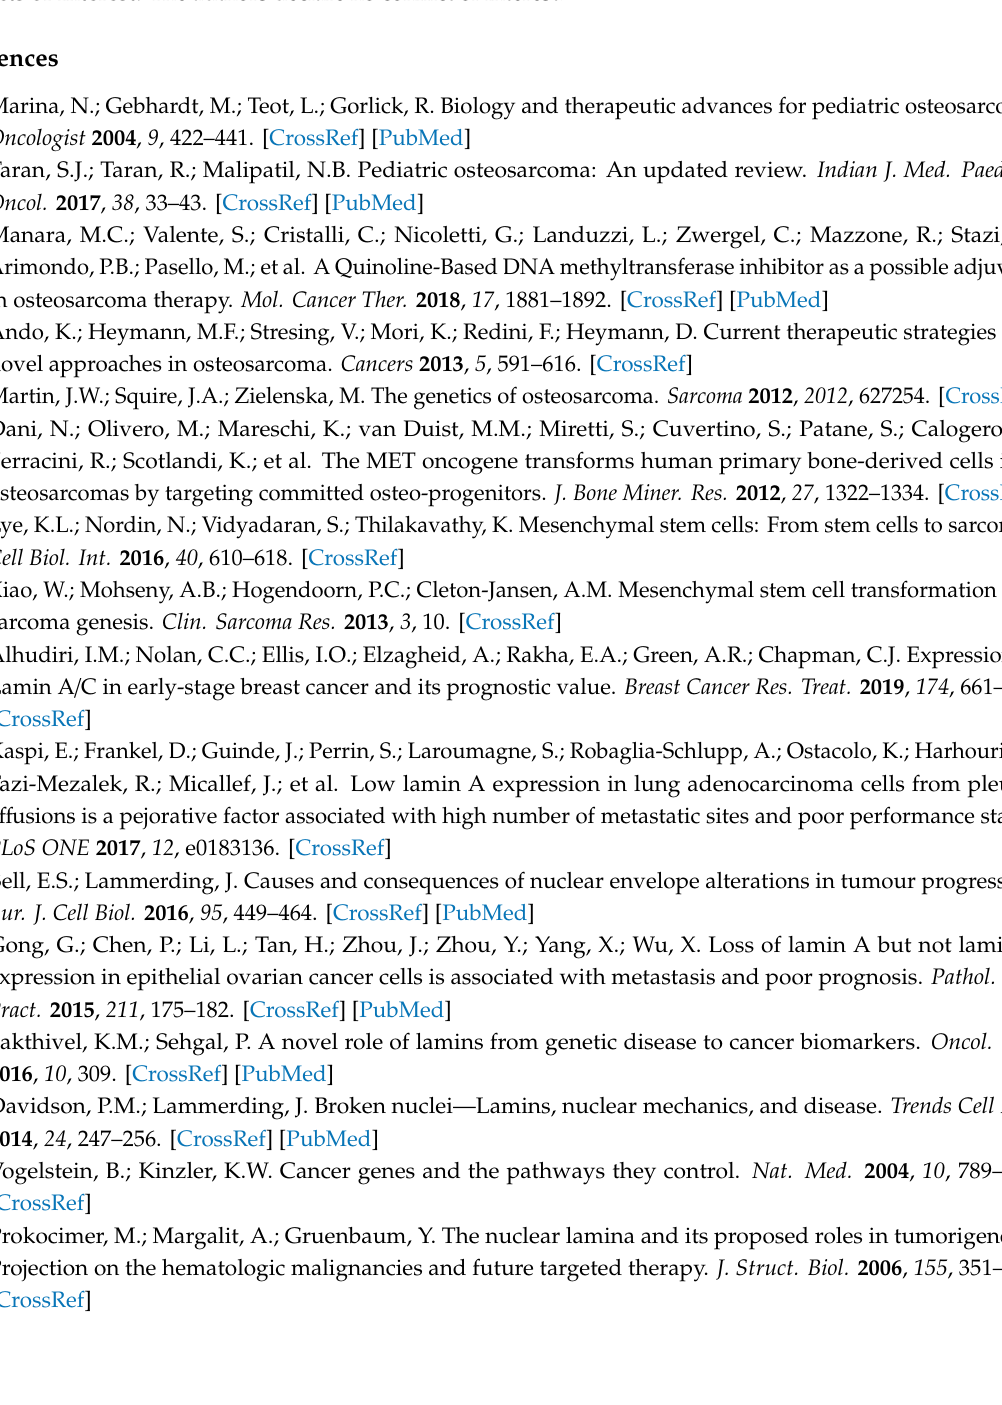
Figure S1: Lamin A / C Expression is Reduced in Osteosarcoma Cell